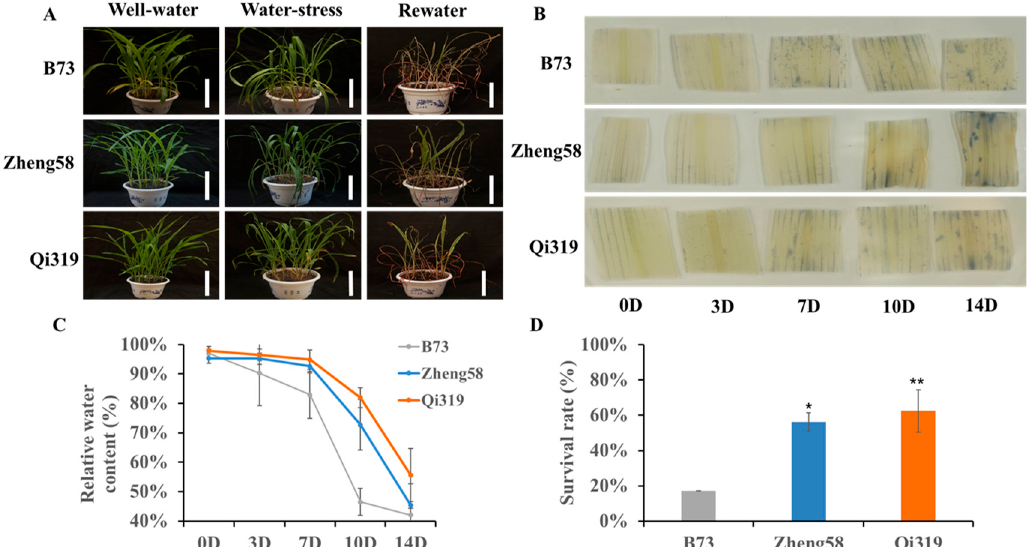
Figure 6. Phenotypes of three maize lines under drought treatment. ( A ) Drought treatment of B73, Zheng58, Qi319 inbred lines at different time points. (White bar = 100 mm); ( B ) ROS production and oxidative damage of three inbred lines under drought stress. NBT staining for superoxide(O 2 − ) (blue, B) in the leaf blades; ( C ) leaf relative water content (RWC) of three maize inbred lines during two weeks of drought stress. The x-axis is the time course of treatment, and seedlings were sampled at 0(CK), 3, 7, 10, and 14 D after drought treatment, respectively. The y-axis shows the relative water content; ( D ) survival rate of drought-treated three maize inbred lines. Bars represent the mean (three or four replicates with each replicate containing 16 plants) ± standard deviation. The x-axis is B73, Zheng58, Qi319 inbred line and the y-axis shows the survival rate of three inbred lines. p -value of < 0.05 (*), < 0.01 (**).